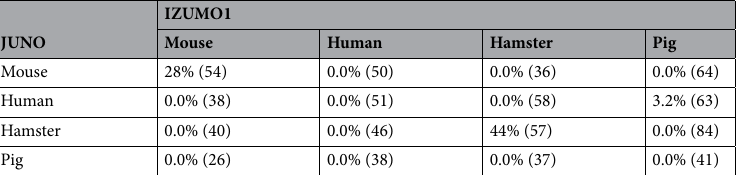
Table 3. IZUMO1 translocation in conspecific and heterospecific cell combinations. Numbers in brackets are the numbers of contacted cell-pairs for each